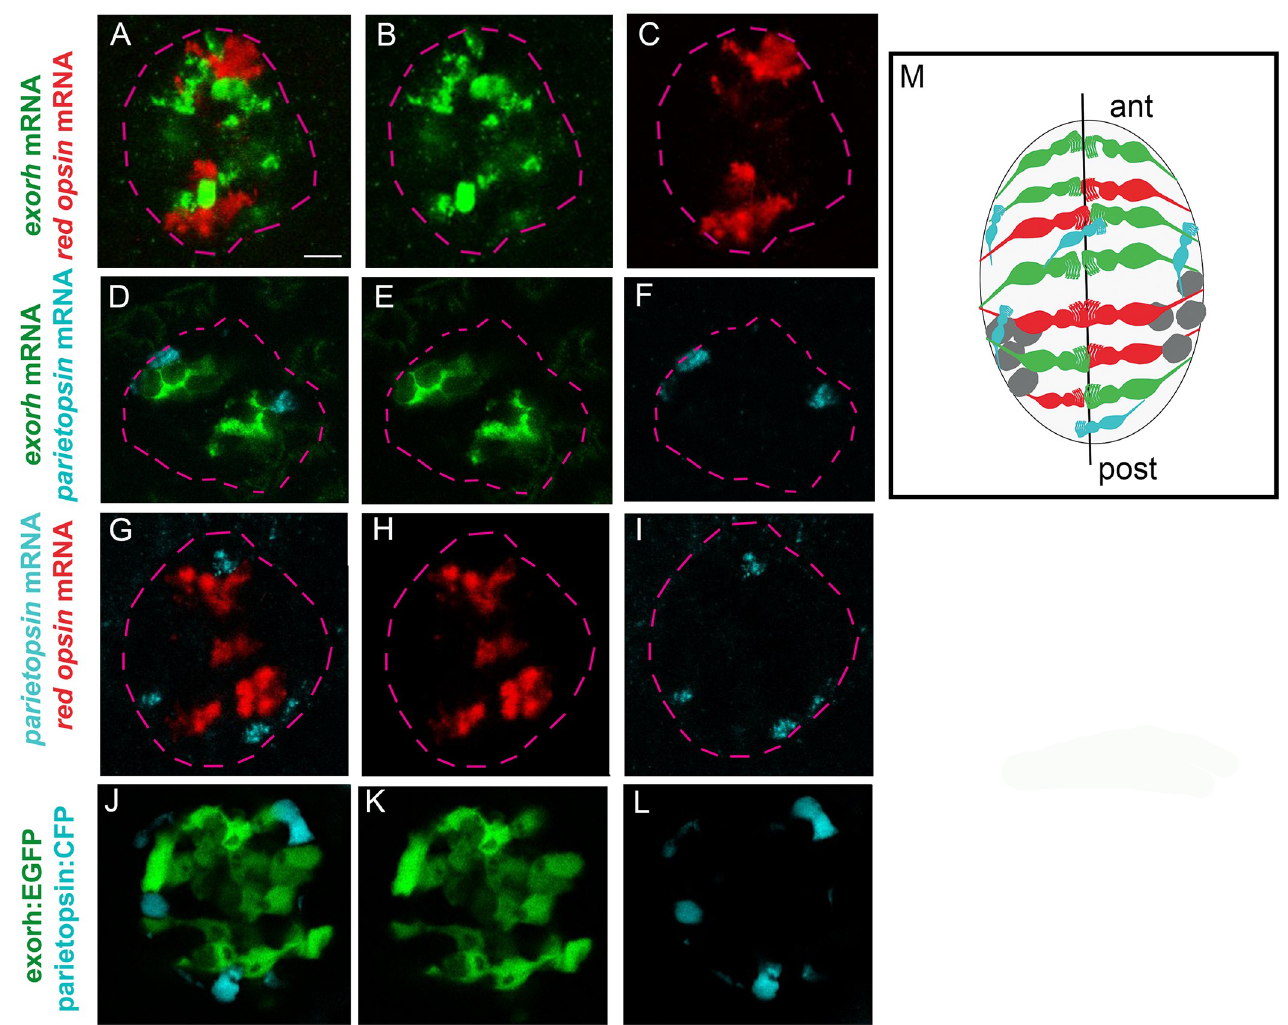
Fig 1. The zebrafish pineal gland contains three PhR subtypes. (A-I) Confocal sections of embryos double labeled for two of the three different opsin probes ( exorh , PT , and red opsin ). Nuclear staining (Topro3) was used to draw a mask delineating the pineal gland; these masks are shown on the panels (dotted pink lines). Embryos shown are 48 hpf. The images are falsely colored to show the exorh+ cells in green, the PT + in blue, and the red + in red. Anterior (“ant”) is on the top. Scale bar represents 10 μ m. (J-L) Confocal sections of live Tg(exorh : EGFP) ja1 ; Tg(-2 . 2parietopsin : CFP) double-transgenic embryos (exorh:EGFP; parietopsin:CFP). Embryos shown are 96 hpf. (M) Schematic representation of the organization of the pineal gland with the orientation as in A-L. The midline is shown with a black line, projection neurons are in gray, and the color code for the PhRs is as in panels A-L. Underlying data can be found in S1 Data. exorh